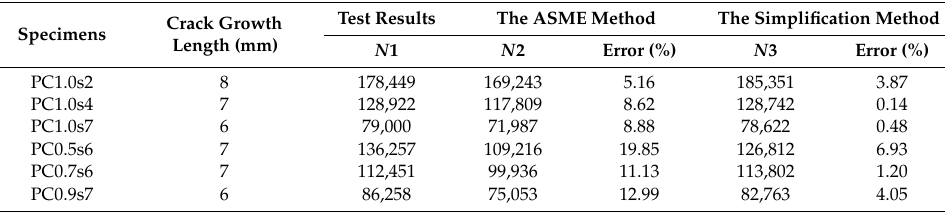
Table 7. Comparison of the two